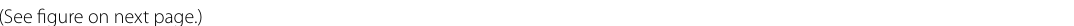
Fig. 4 Knock-down of DDIT4, MT1X, SERPINE1 and CTSD in MDA-MB-231 F2 cells revealed a role in breast cancer invasion. a qRT-PCR amplification quantifying knockdown of the respective gene within the MDA-MB-231 F2 population. Notably, expression of all genes was reduced to near parental expression levels. b After 24 hours, ECM embedded cell clusters of various knockdown and wildtype lines were quantified using ImageJ for invasion. Invasion is measured as relative area of cells that escape the cluster. c Representative immunofluorescence images (left panel of each pair) of embedded clusters stained for Hoechst (blue) and Phalloidin (red). Digitally zoomed insets taken from the full-sized image and highlighting invasion at the borders are provided (right panel of each pair). Insets correspond to dashed boxes on original scale image. Scale bars * p -value < .01; ** p -value < .001; *** p -value = = =